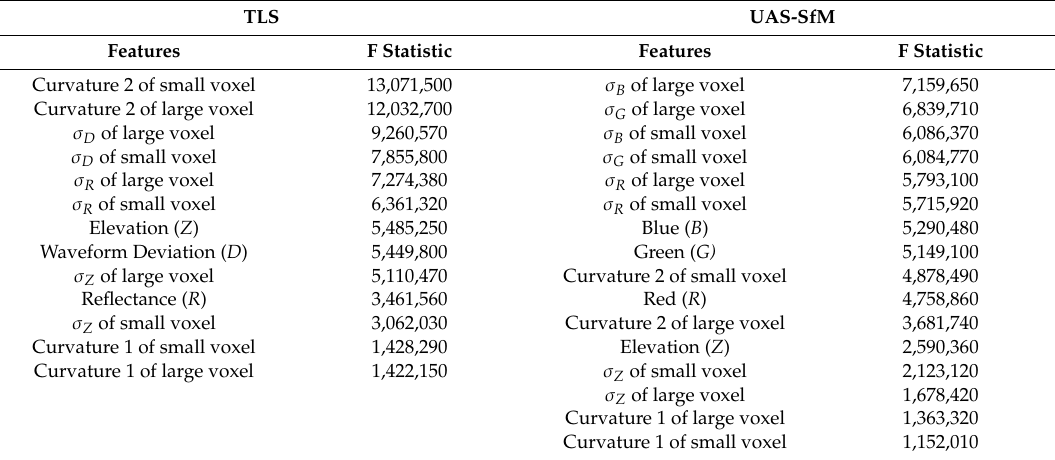
Table 10. Rankings of feature separability based on computed F statistic values for TLS and UAS-SfM for 7 clusters. σ = standard deviation. For TLS, Z = elevation, R = reflectance, D = waveform deviation. For UAS-SfM, R = Red, G = Green, B = Blue. TLS